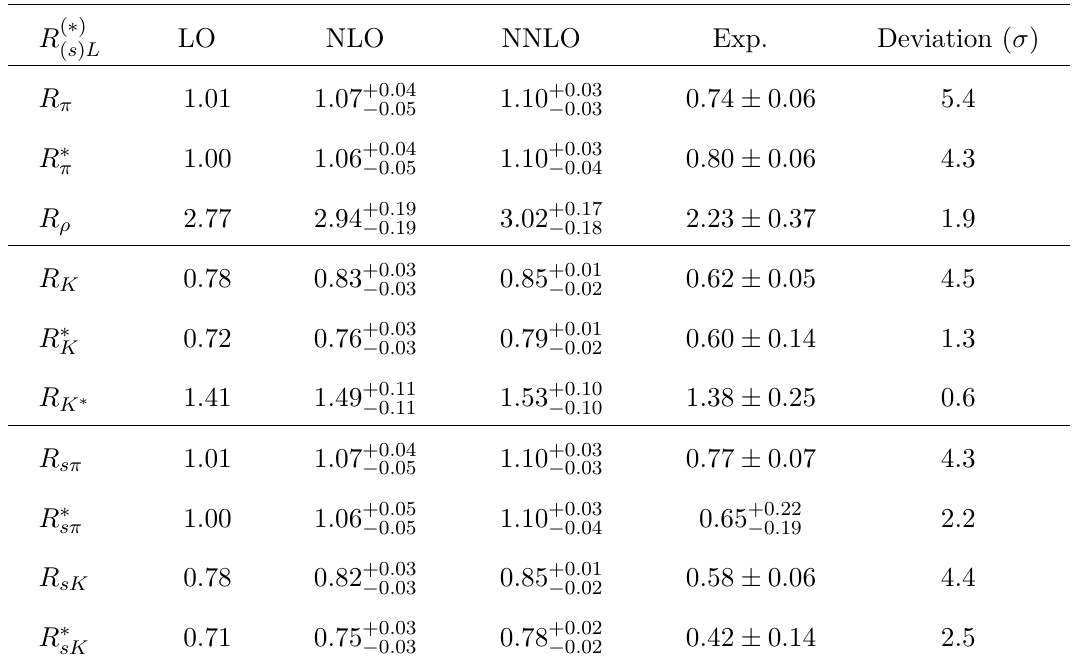
Table 6 . Theoretical and experimental values of the ratios R ( ∗ ) and 10 − 1 GeV 2 for b → c ¯ us transitions, respectively. The levels of deviations between the NNLO predictions and the current experimental data are shown in the last